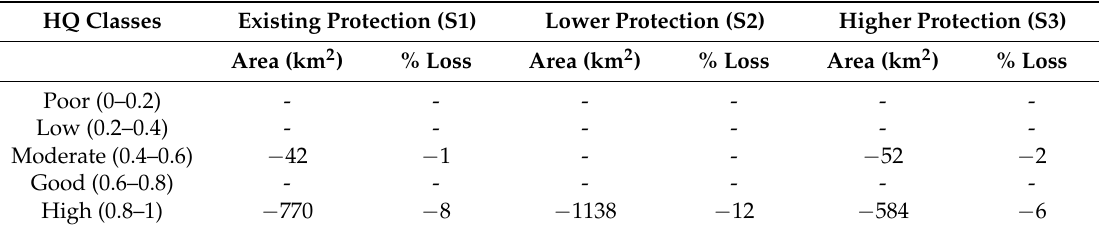
Figure 2. Protected areas and current and proposed infrastructure network of the Terai Arc Landscape. Table 2. Losses in habitat quality (HQ) scores in the landscape (“-” = No